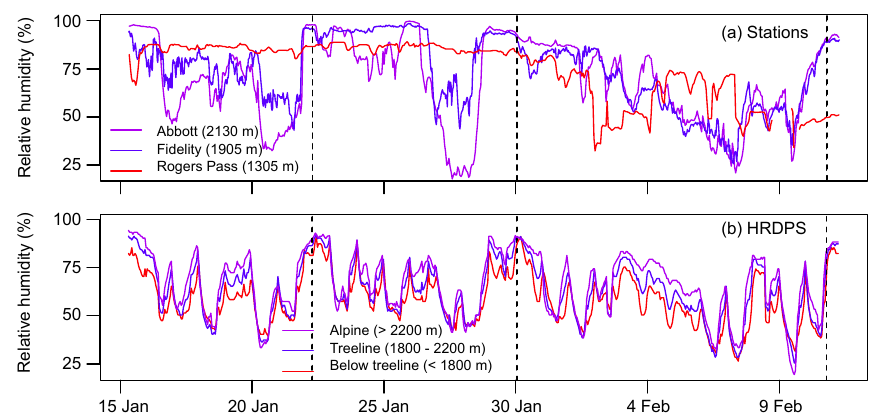
Figure 4. Relative humidity (a) measured at stations and (b) forecast by the High-Resolution Deterministic Prediction System (HRDPS) in Glacier National Park. Same format as Fig. 3.